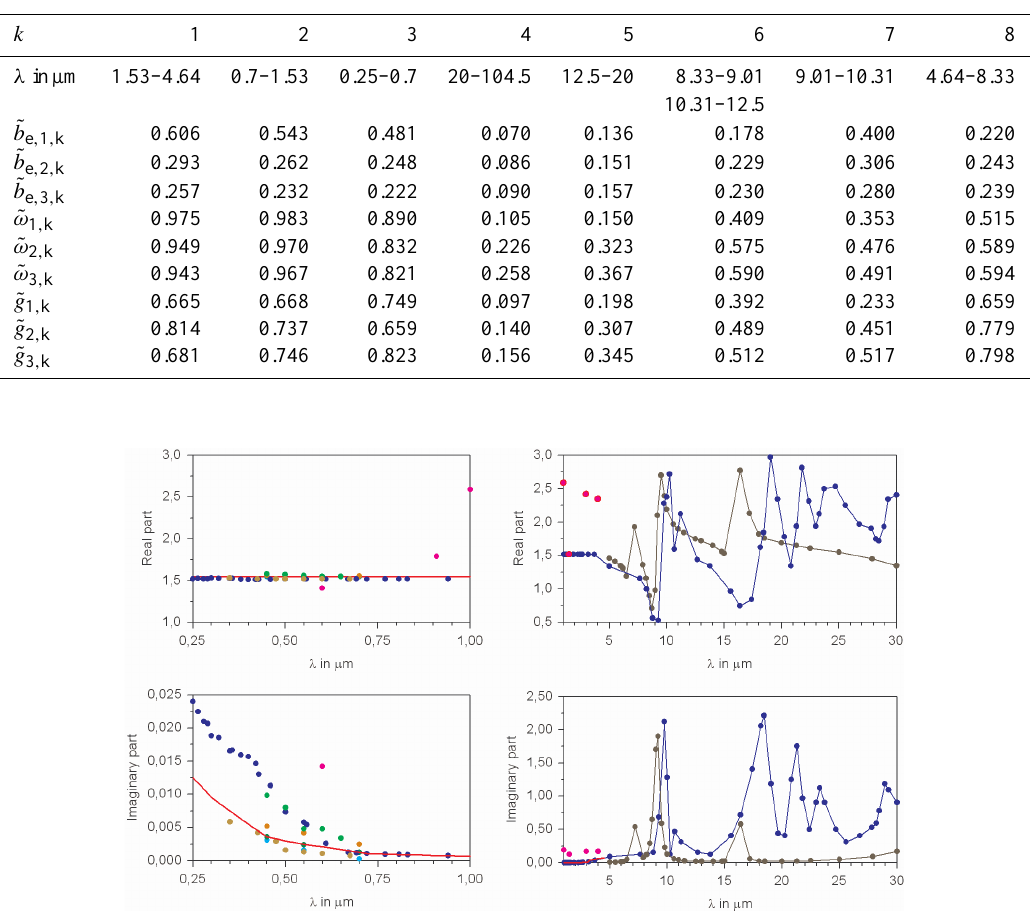
Figure 1: Refractive indices for mineral dust of different studies (red: values used in run F; blue: Tegen, used in Helmert et al. (2007) and in the longwave spectrum in run F; pink: Volz (1973); brown: Sinyuk et al. (2003); green: Patterson et al. (1977); orange and light blue: Petzold et al. (2009) episodes 1 and 3; grey: Volz (1972a,b) and Shettle and Fenn (1979)).